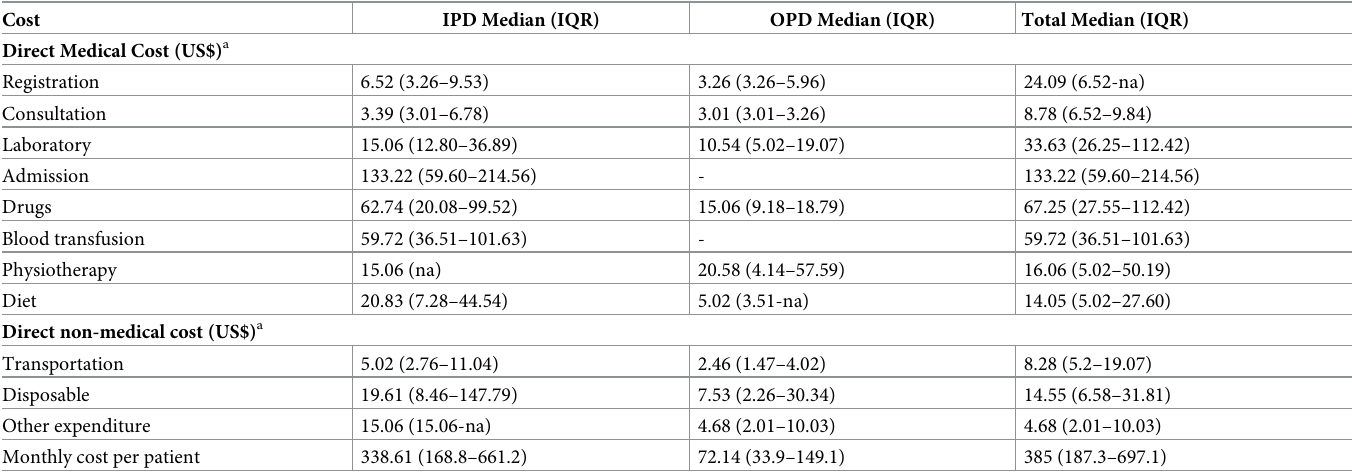
Table 2. Direct cost of SCD per month reflecting unit cost.